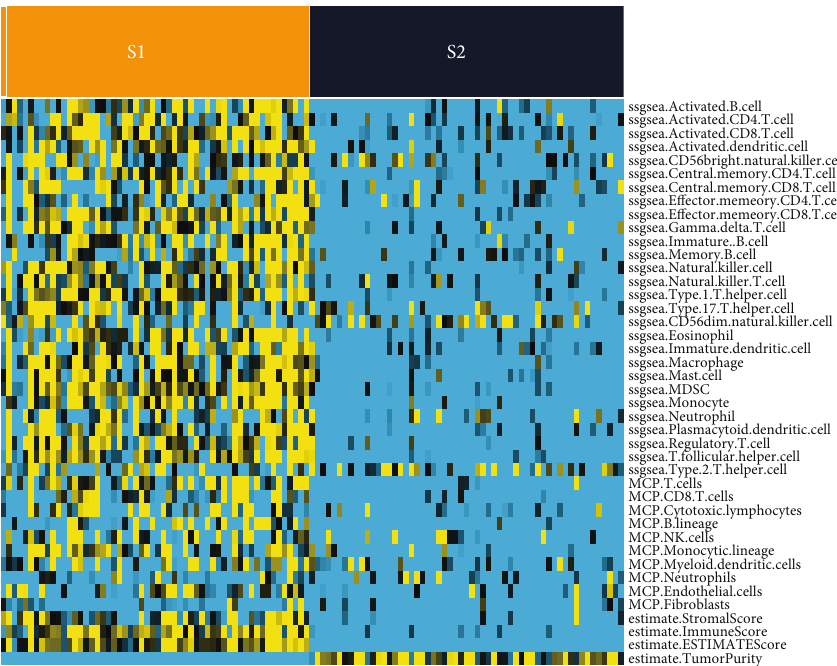
Figure 3: Cell scores in two di ff erent NPC subtypes are illustrated by the heat map (yellow: higher value; blue: lower